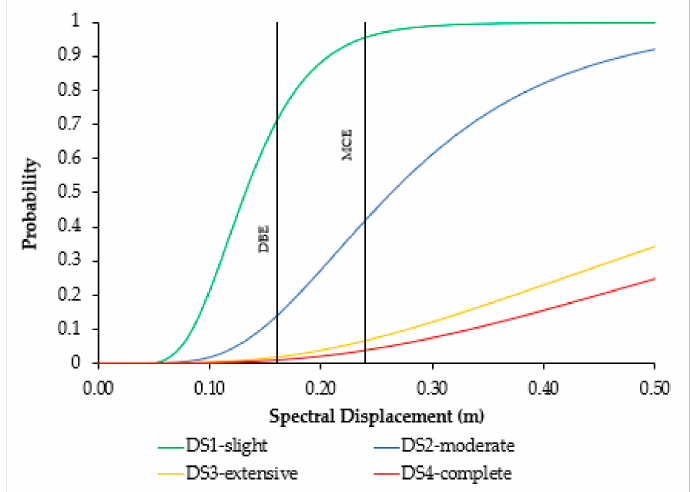
Figure 13. Fragility curve at various damage state